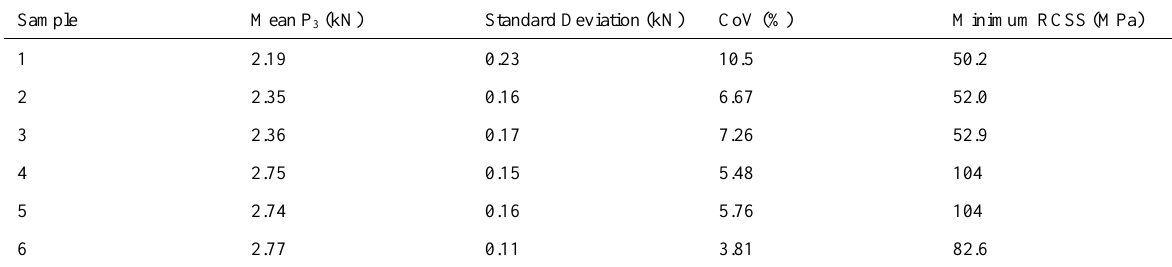
Table 3. Sample statistics displaying mean P 3 , standard deviation, coefficient of variation (CoV), and minimal residual compressive surface stress of all